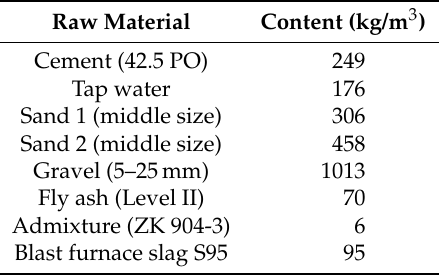
Figure 5. Elements of the tested structure and positions of thermocouples and strain gauges. Table 1. Composition of the concrete used for the tested structure.